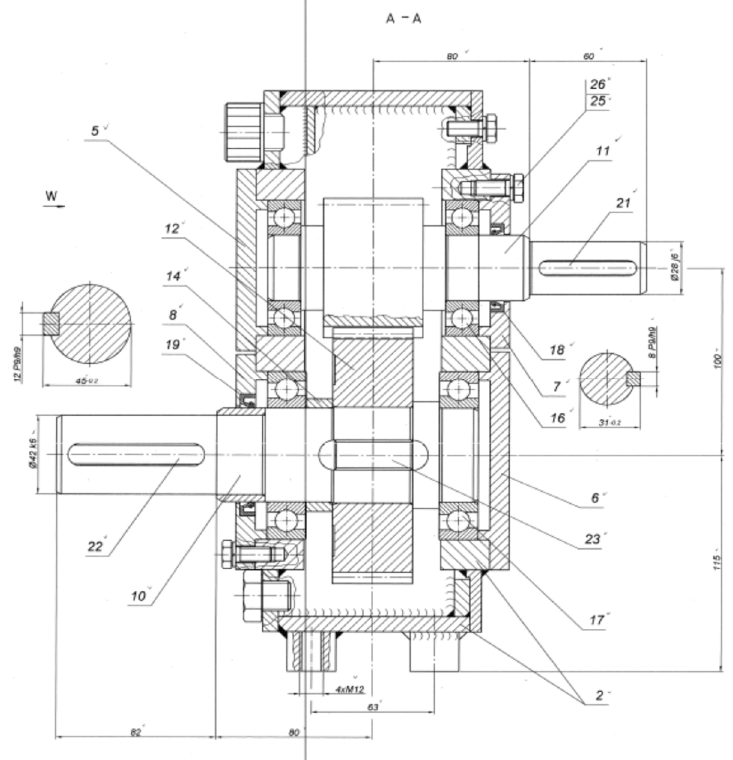
Figure 6. Diagram of the analyzed gearbox. 2—body; 5, 6, 7, 8—bearing caps; 10—shaft; 11—pinion; 12—tooth gear; 14—spacing rings; 17; 16—bearings; 18, 19; —seals; 21, 22, 23—keys; 25, 26—washers; screws.